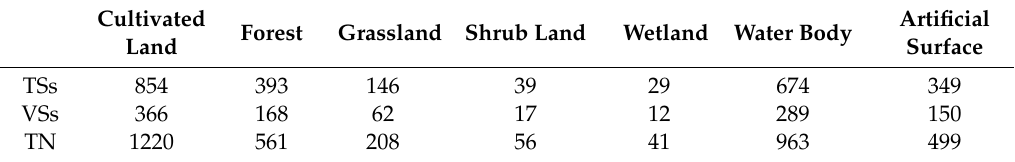
Table 1. Summary of sampling sites in the Three Gorges Reservoir Catchment (TGRC).